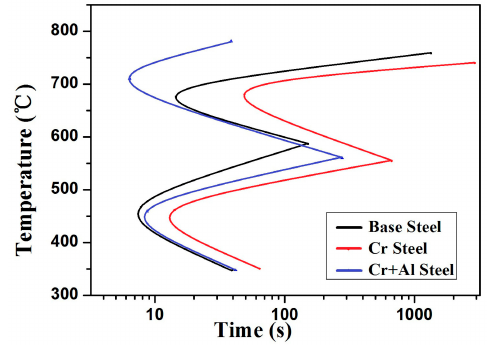
Figure 2. The time–temperature ‐ transformation (TTT) curves of three steels.